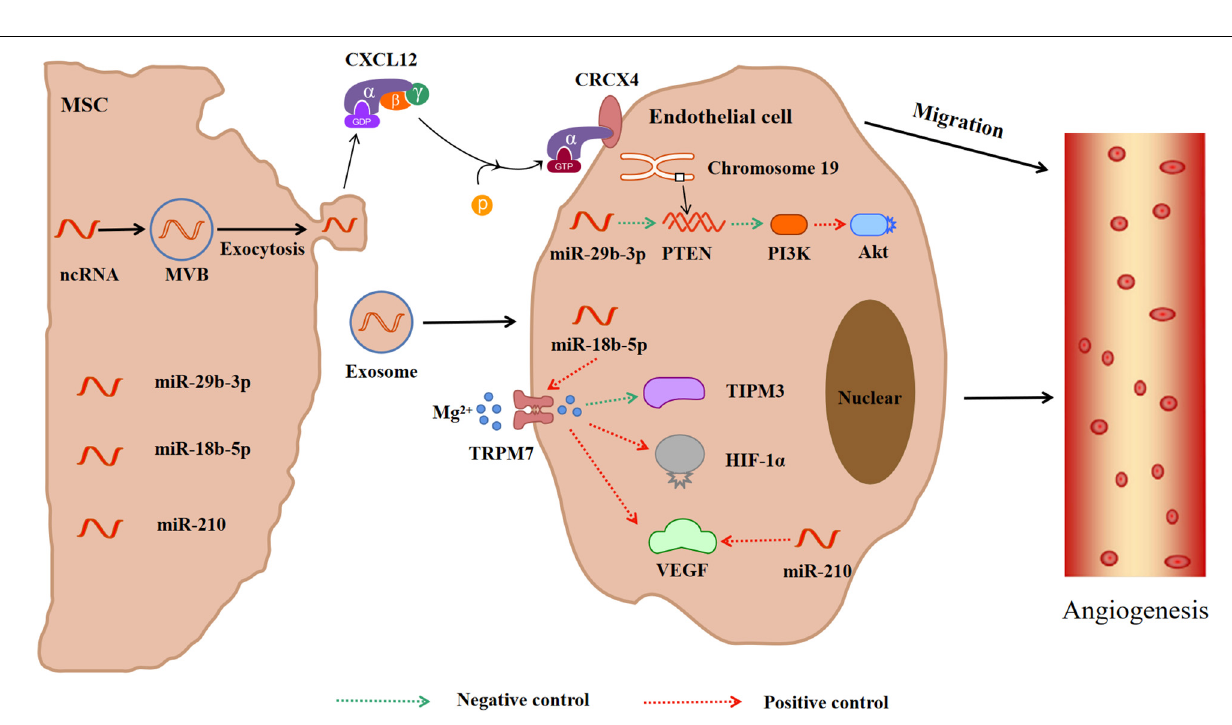
Frontiers in Neuroscience |